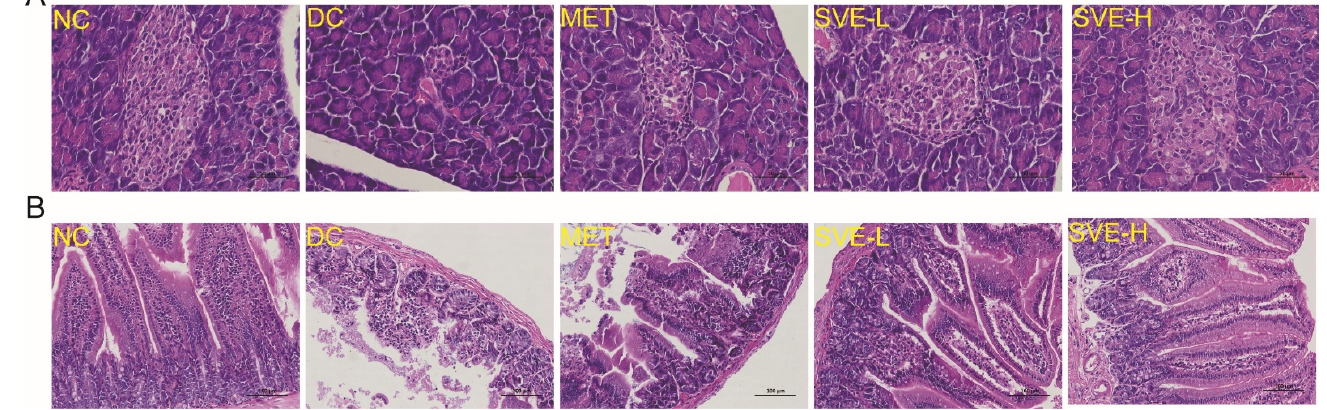
Figure 3. Histopathological analysis of pancreas ( A ) and jejunum ( B ) tissues in different groups with hematoxylin and eosin staining at 400× and 200× magnification, respectively. Note: The yellow letters in figures represent the different groups.